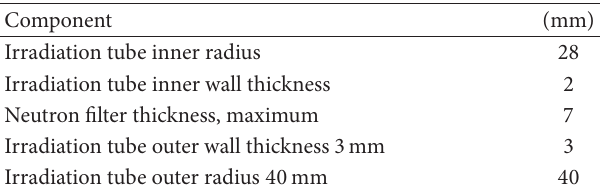
Table 4: Dimensions of the irradiation tube [17].